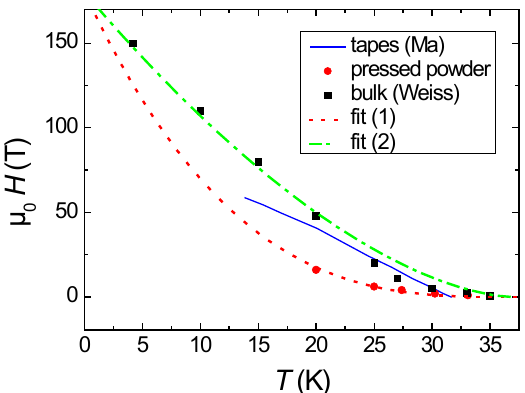
Figure 5. Irreversibility fields, H irr , for the reacted-and-pressed powder sample ( ), tapes indicated by a blue line ( ) [39], and the HIP-treated bulk sample ( (cid:4) ) of Weiss et al. [16]. Details of the fits (1) and (2) are described in the main text.